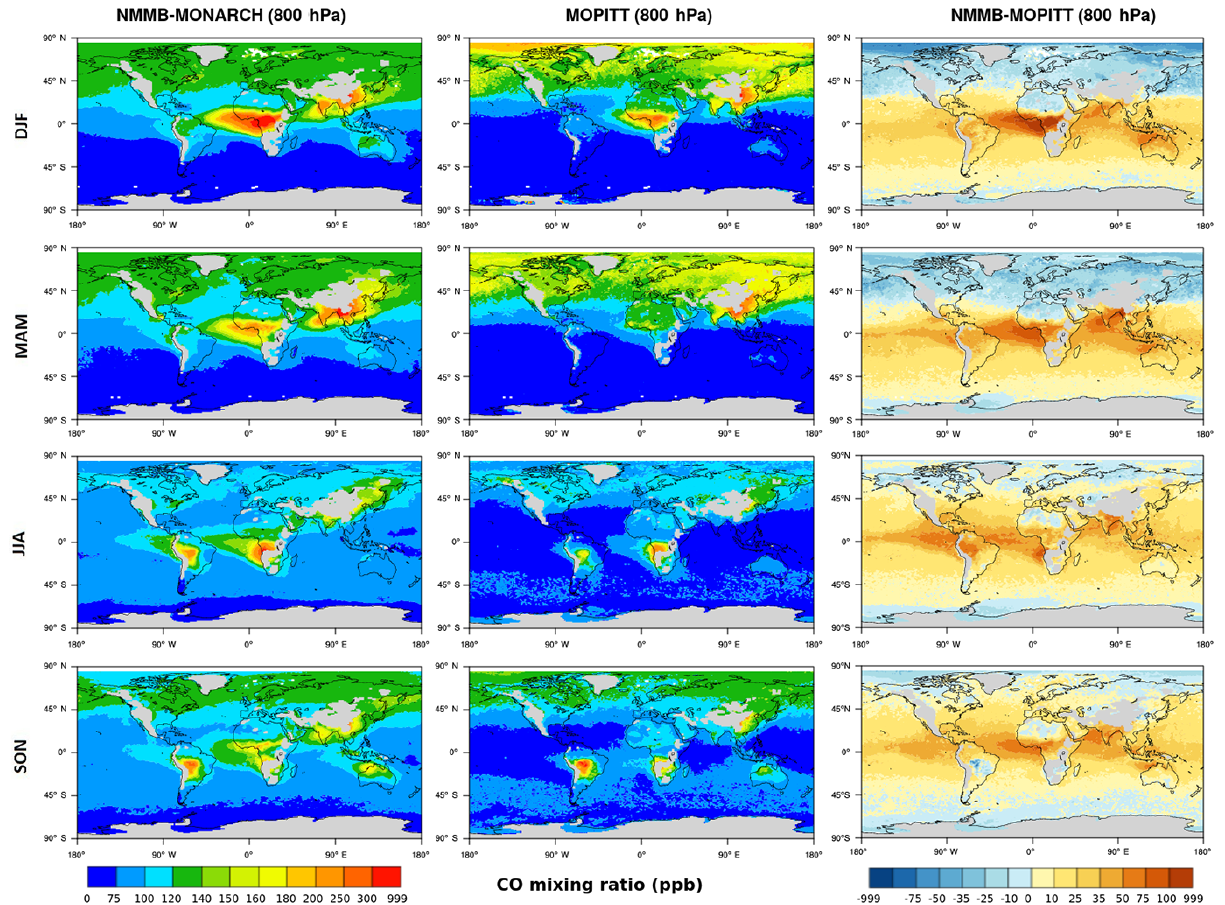
Figure 6. Comparison of the modeled CO mixing ratio at 800hPa against satellite data (MOPITT) in ppb. From top to bottom: DJF for year 2004. NMMB-MONARCH data are displayed in the left panel, MOPITT data in the middle panel, and the bias in the right